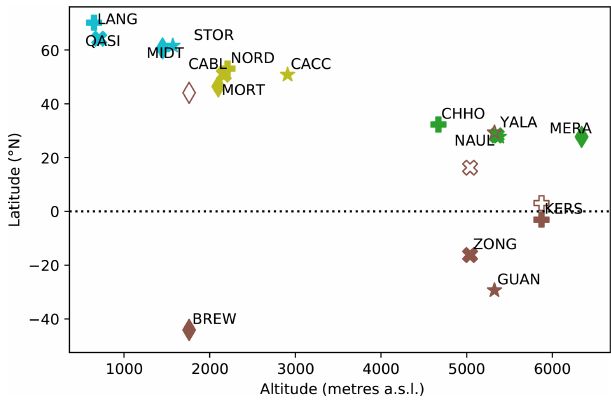
Figure 2. Altitude and latitude of study sites. Open symbols show the position of Southern Hemisphere sites against Northern Hemi- sphere sites for